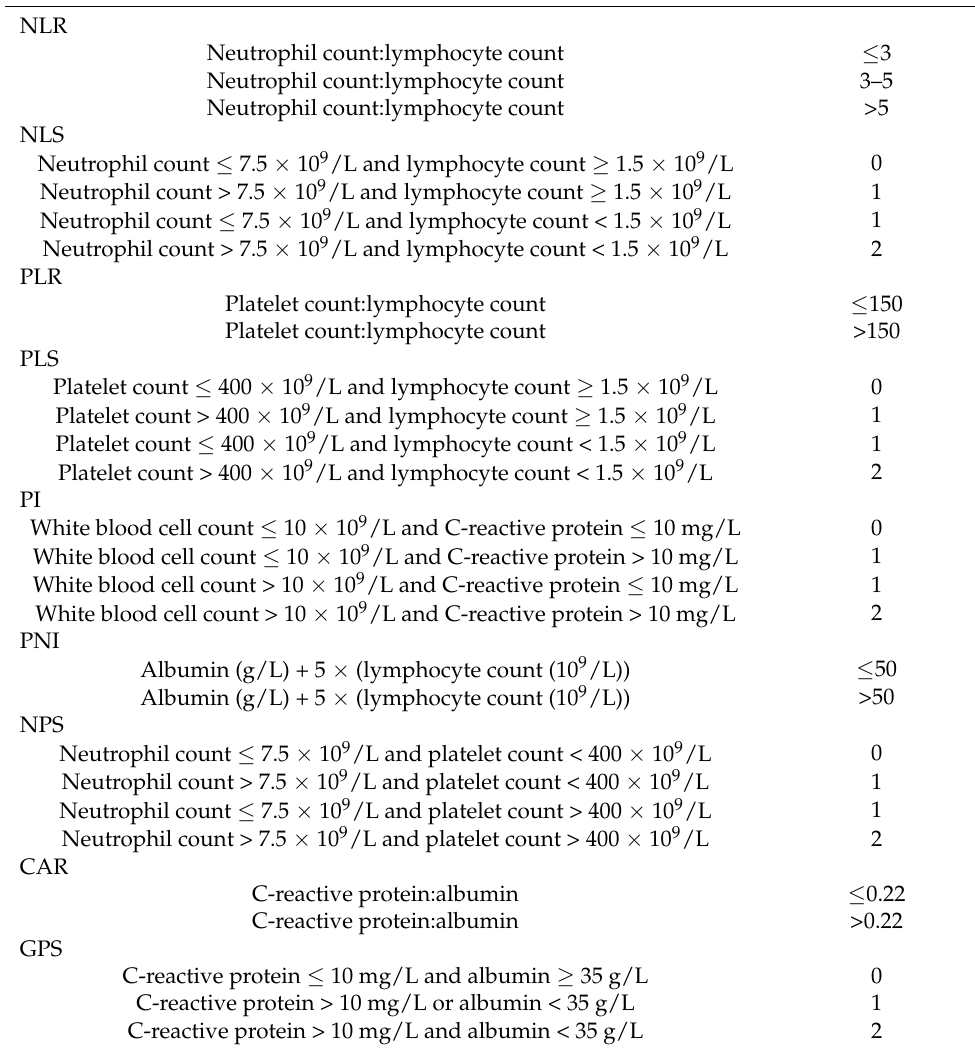
Table 1. Systemic-inflammation-based prognostic ratios and scores.